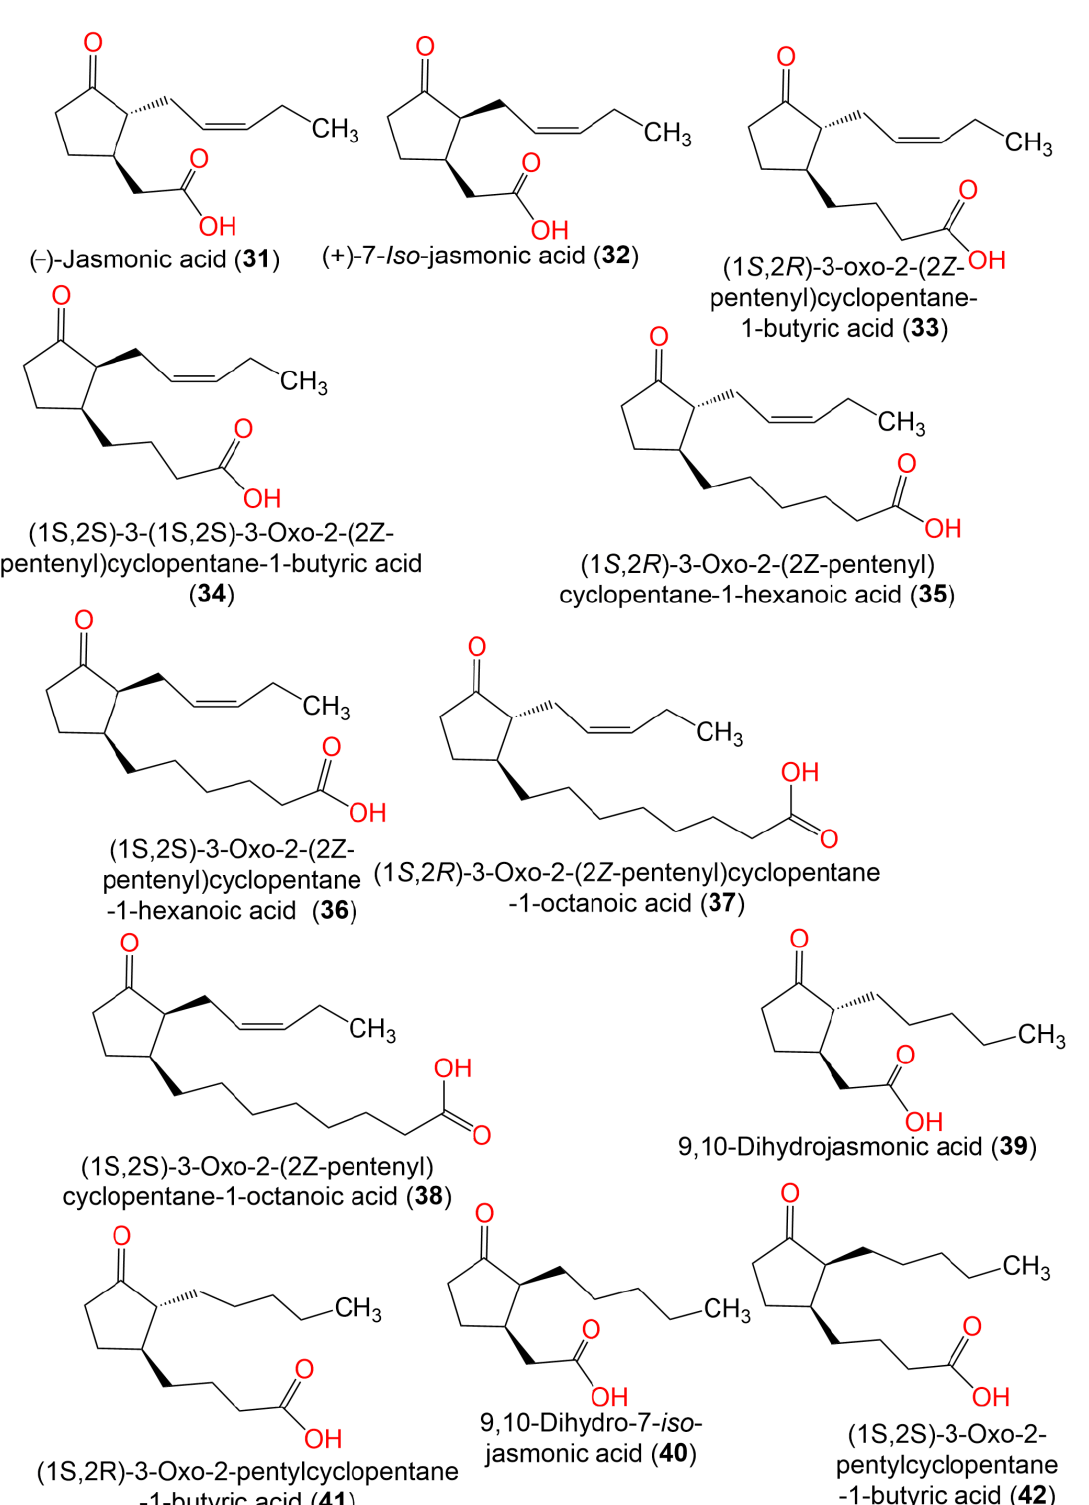
Figure 3. Structures of jasmonates derivatives ( 31 – 42 ) isolated from F. oxysporum .